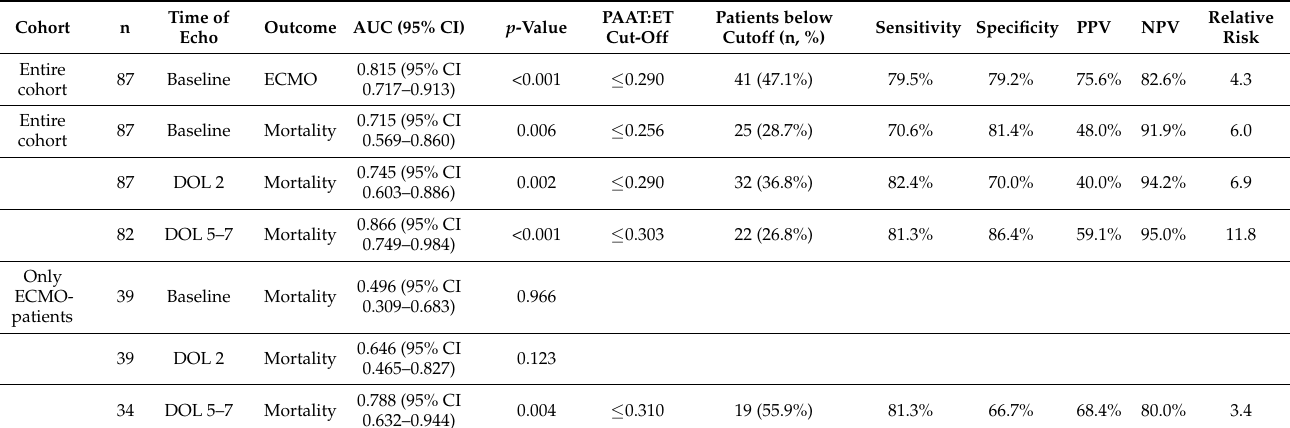
Table 2. Area under the curve (AUC), sensitivity, specificity, positive predictive value (PPV), neg- ative predictive value (NPV) for pulmonary artery acceleration time to right ventricular ejection time (PAAT:ET) measurements obtained at baseline, DOL 2, and DOL 5–7. ECMO, extracorporeal membrane